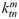
Sample of the simulated torque responses and the corresponding variability given different simulated interaction conditions across 25 simulation trials.The simulated spherical hard nodule of size 15 mm diameter is presented at location between 100 mm to 115 mm. The simulated interaction conditions for each sub-figure are as follows: (a) The average stiffness of soft silicon phantom is varied with the other parameters fixed at ra = 8mm, i = 4mm, and vprobe = 20mm/s. (b) Average Stiffness of the probe is varied keeping the other variables fixed at ktnm = 95N/m, i = 4mm, and vprobe = 20mm/s. (c) The indentation level of the probe, i, is varied keeping the rest parameters fixed at ktnm = 95N/m, ra = 8mm, and vprobe = 20mm/s. (d) The probing speed, vprobe, is varied and the other parameters are kept at ktnm = 95N/m, ra = 8mm, and i = 4mm. For each torque profile measured during palpation, the maximum torque at the location of simulated hard nodule is extracted. Sub figures (e), (f), and (g) show the average maximum torque felt with error bars, under different combinations of probe’s internal stiffness, indentation, and PSV.